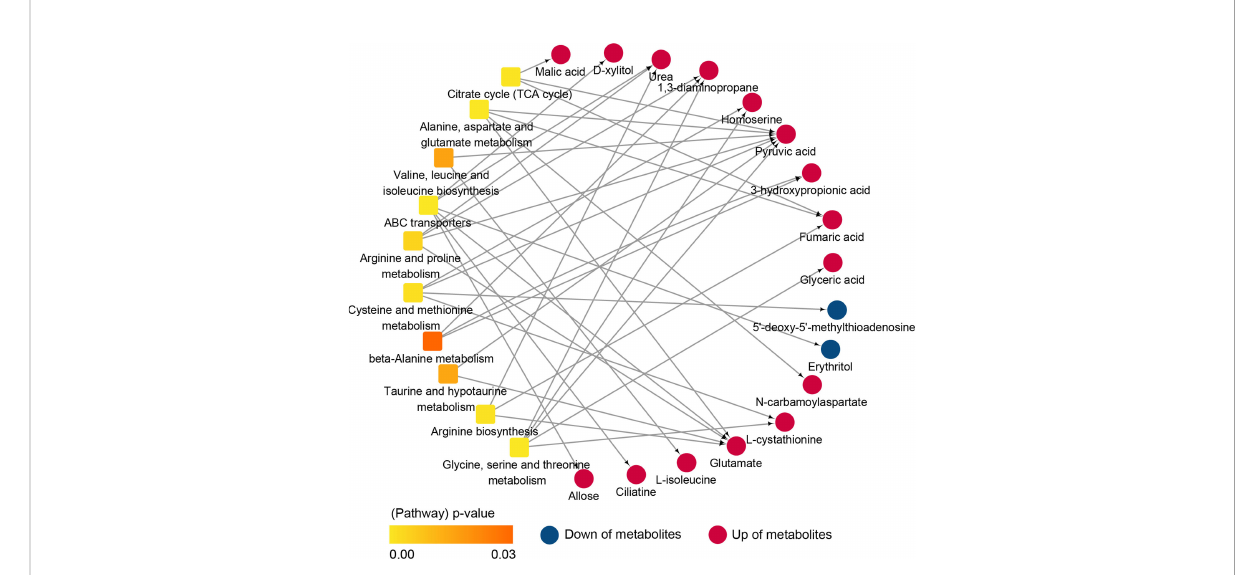
FIGURE 5 Interaction network diagram of metabolic pathways and differential metabolites